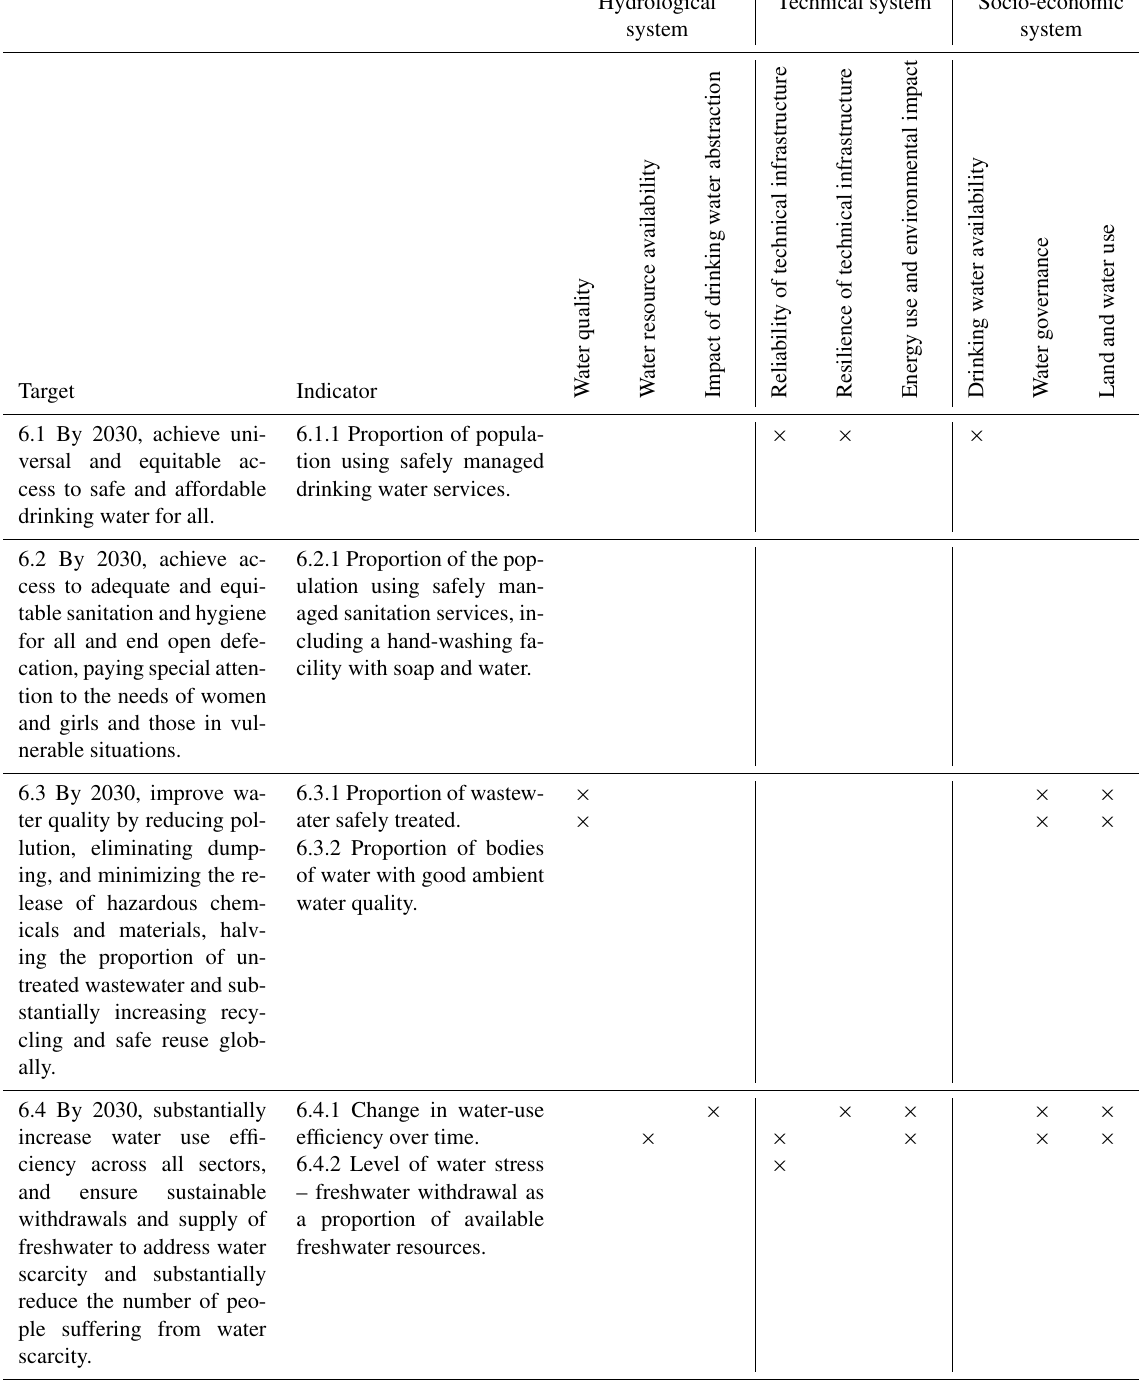
Table D1. Summary of the Sustainable Development Goal 6 targets and indicators related to sustainability